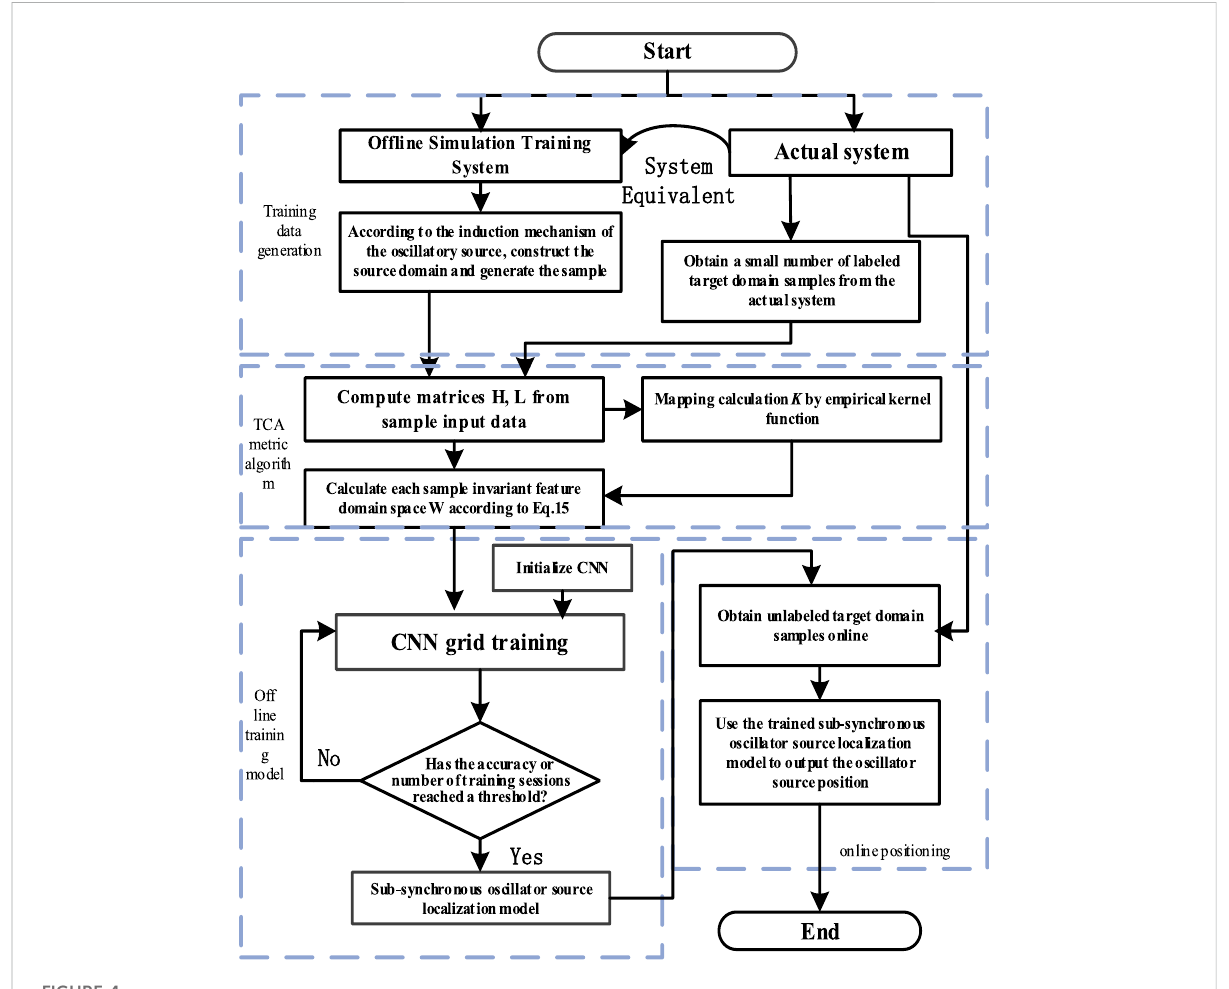
FIGURE 4 Single-machine equivalent model of the grid-connected wind